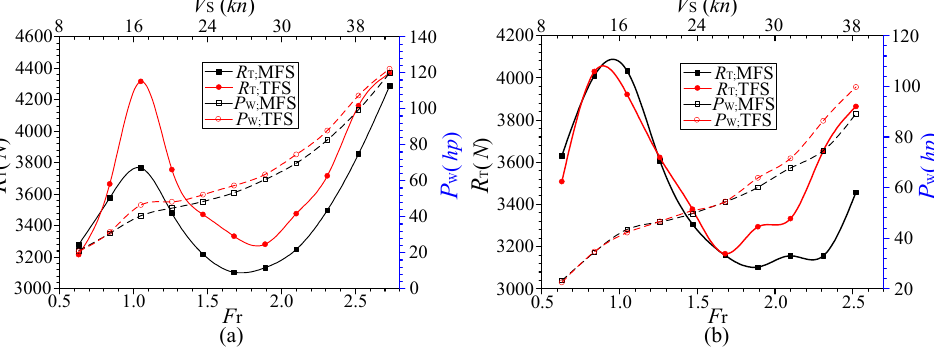
Figure 34. The R T , power ( P W ) curves of the real ship in the MFS and TFS under ( a ) condition two, ( b ) condition 3.